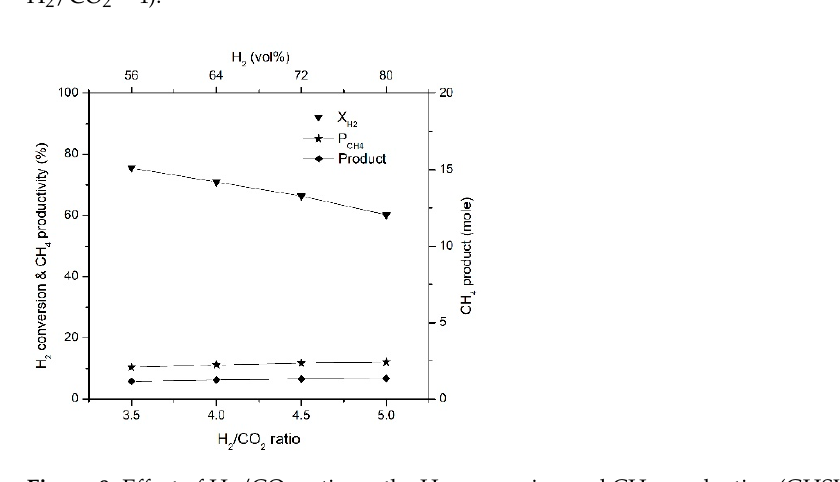
Figure 8. Effect of H 2 /CO 2 ratio on the H 2 conversion and CH 4 production.(GHSV = 30,000/h).